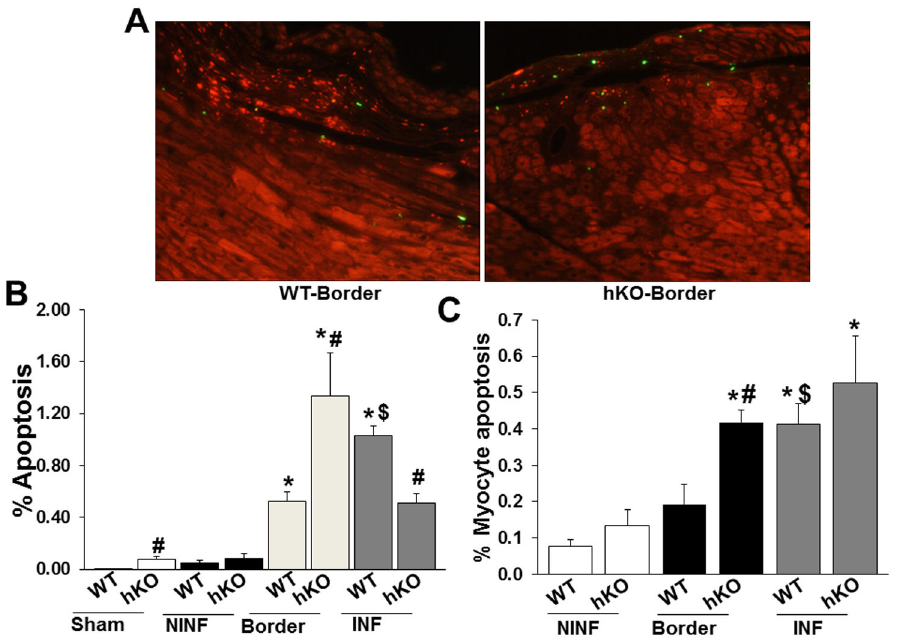
Figure 4. Analysis of apoptosis. A. TUNEL-stained images from the border regions of WT and hKO hearts post-MI. B. Quantitative analysis of cardiac cell apoptosis in the non-infarcted (NINF), border and infarct (INF) regions of WT and hKO mice 7 days post-MI. C. Quantitative analysis of myocyte apoptosis in the NINF, border and INF regions of WT and hKO mice 7 days post- MI. *p<0.05 vs sham; #p<0.05 comparisons between WT and hKO groups; $ p<0.05 vs border; n=4. doi: